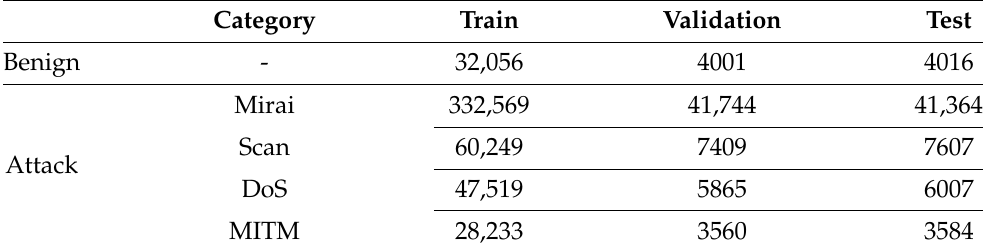
Table 2. Count Statistics of the IoTID20 dataset.